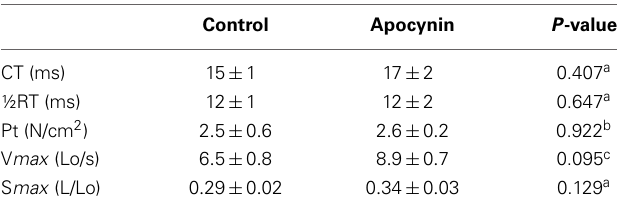
reported sternohyoid muscle weakness in adult male Wistar